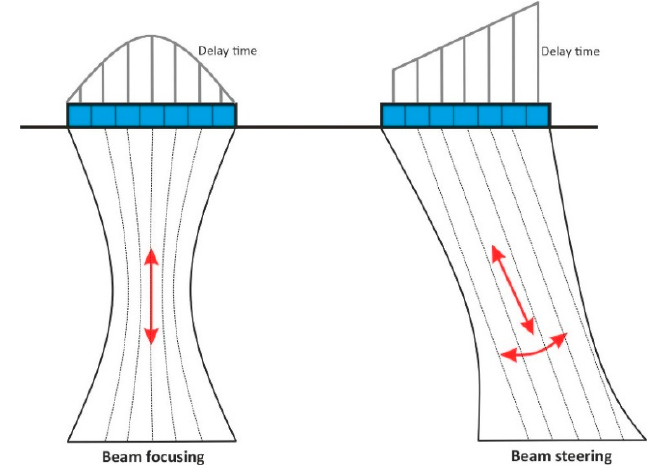
Figure 4. Schematic representation of phased array technique.